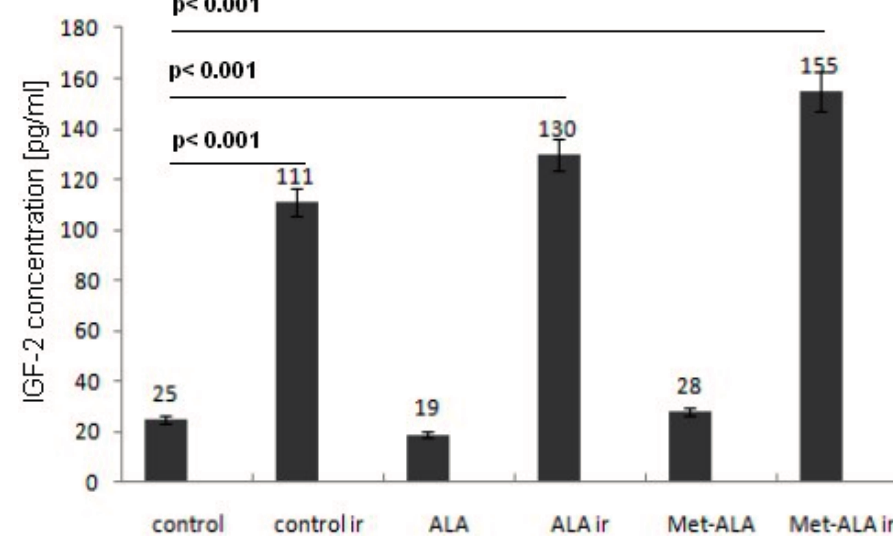
Figure 6. Results from the ELISA test performed on SW620 human colon cancer cells exposed to 3 mM 5-ALA or met-ALA and 4.5 J/cm 2 light or left without light treatment and in control cells (no precursor, no light) or light only. A significant increase in IGF-2 concentration was found after photodynamic therapy (PDT) and light only ( p < 0.05). Data are presented as the means with 5% statistical error from two experiments; ir,